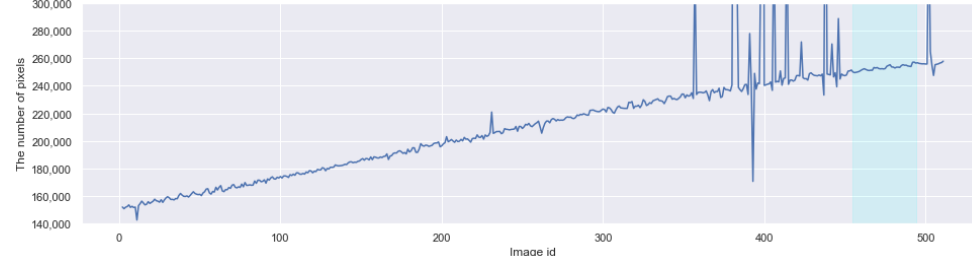
Figure 13. The number of pixels of the masks predicted by CROP for the period 12 August–15 October 2020. Outliers are plotted inside and outside the range. The five days highlighted by cyan color is treated separately in Figure 14.